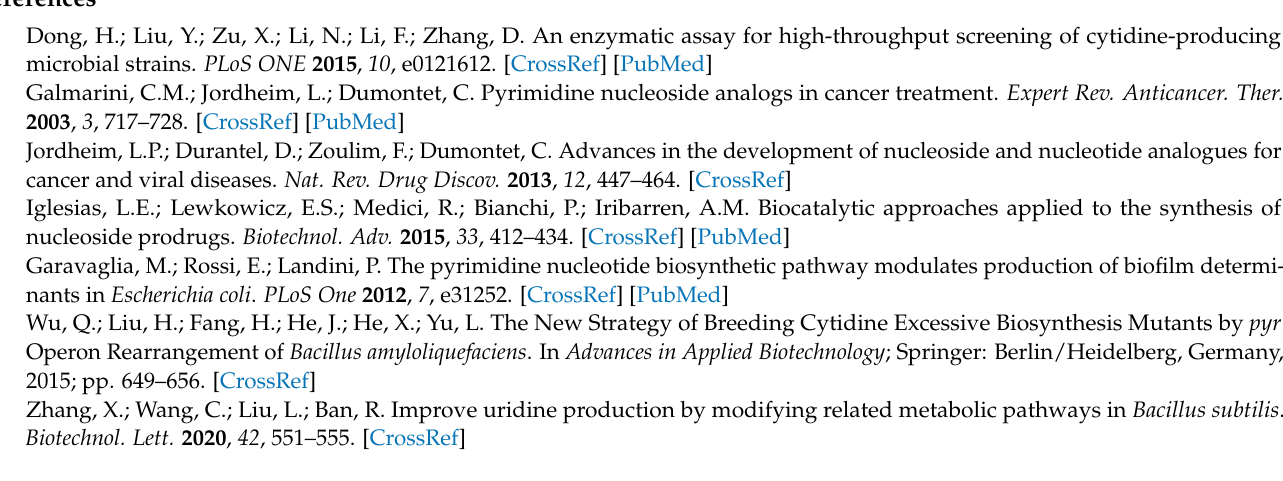
control comparison results; Table S5: Sequencing data quality